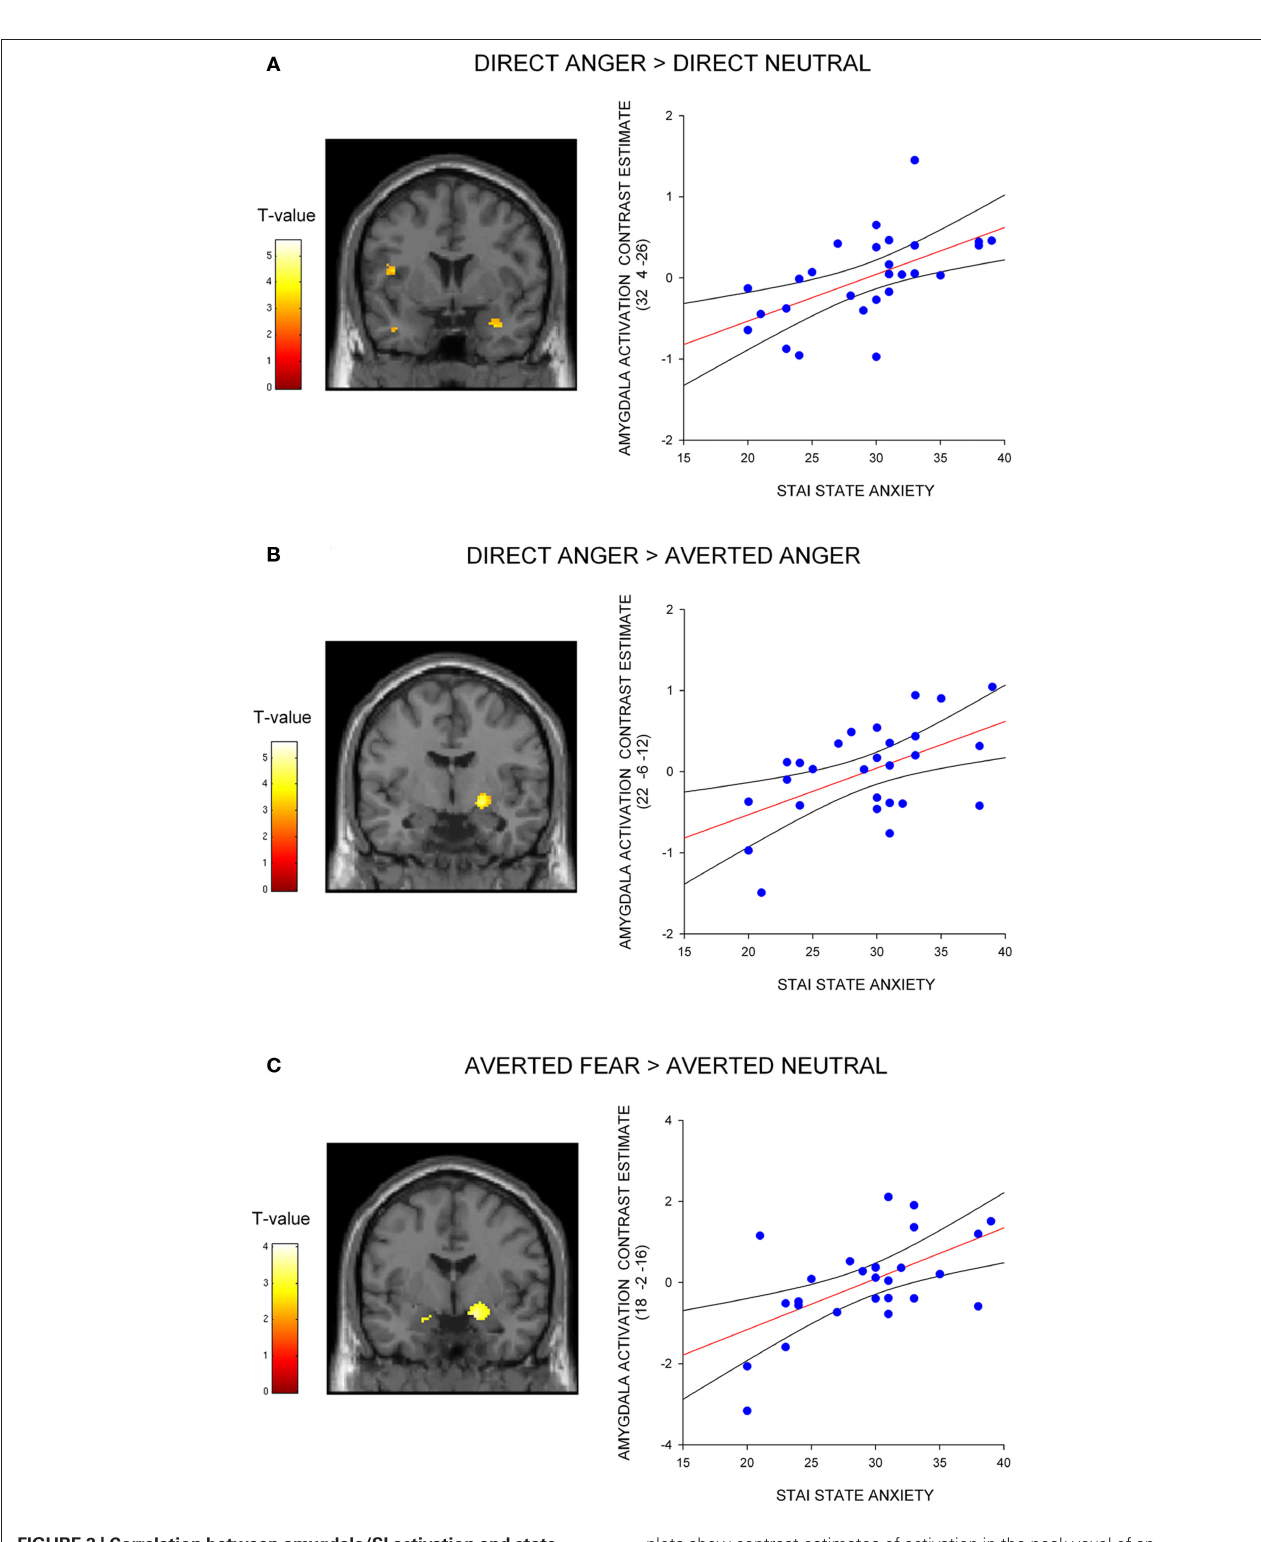
FIguRe 2 | Correlation between amygdala/SI activation and state anxiety shown on a coronal section of a canonical weighted T1 image for (A) direct gaze anger faces compared to direct gaze neutral faces (B) direct gaze angry faces compared to averted gaze angry faces, and (C) averted gaze fearful faces compared to averted gaze neutral faces. Scatter